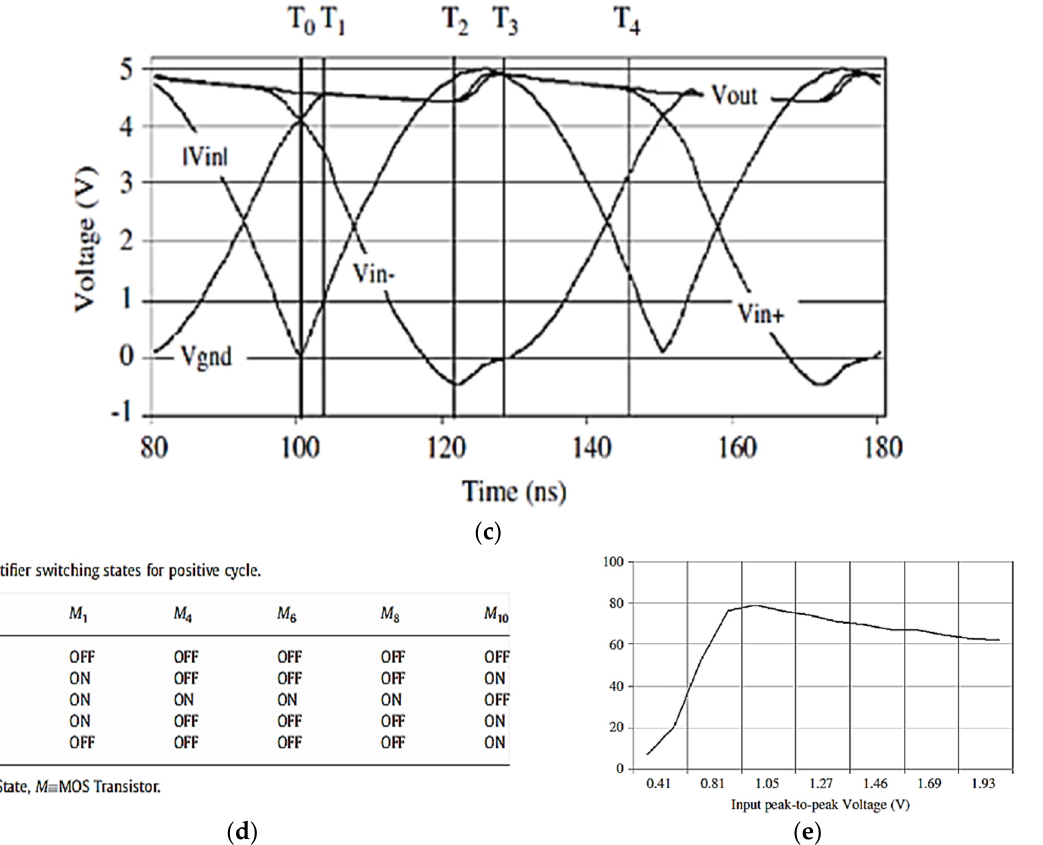
Figure 6. ( a ) Active rectifier using pull-up technology [6]. ( b ) Schematic diagram of the half-wave cycle for each transistor initialization [6]. ( c ) Simulated pull-up active rectifier output results [6]. ( d ) Rectifier switching states for positive cycle [6]. ( e ) power conversion efficiency and input Voltage scan [6]. Reprinted with permission from Ref. [6]. Copyright © 2009 Elsevier Ltd.